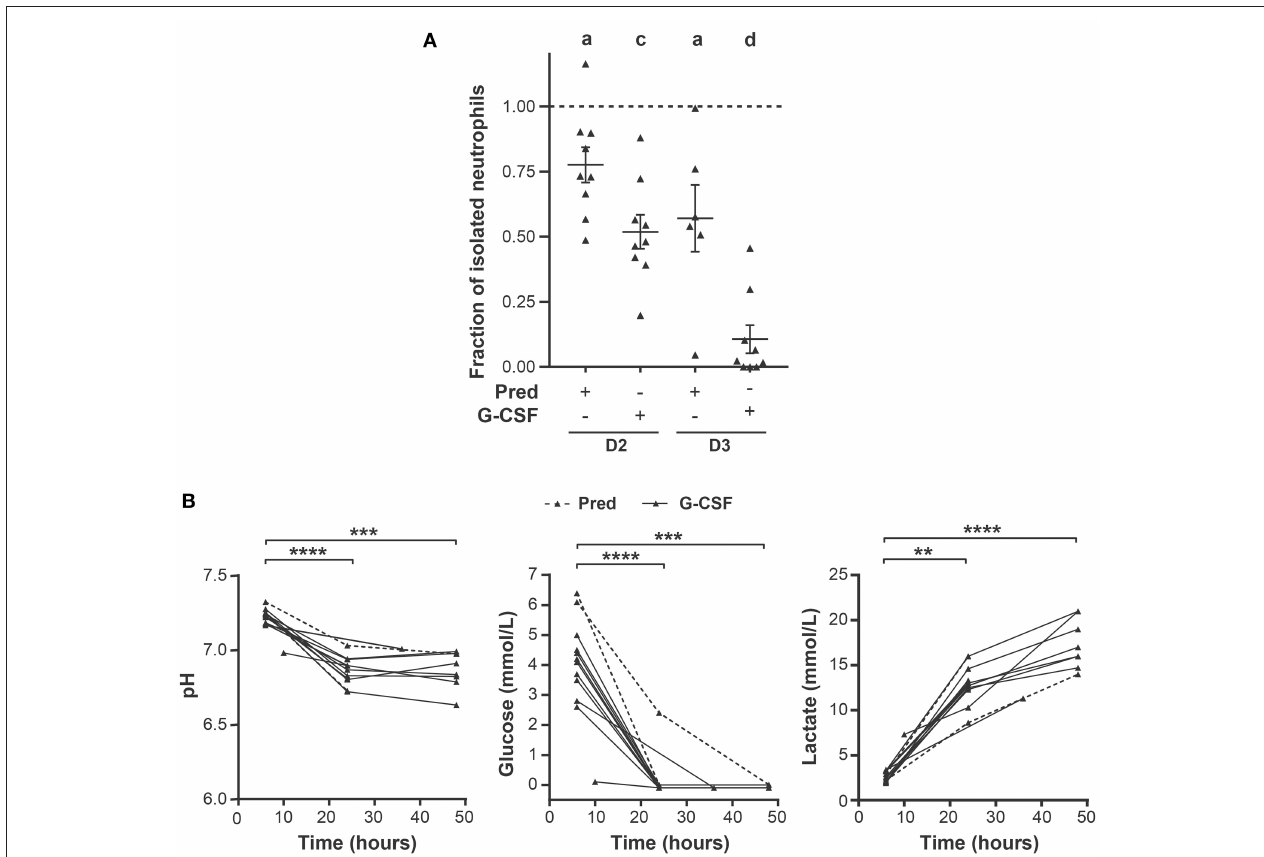
FIGURE 5 | Effect of storage on neutrophil isolation from GCs and GC metabolite composition. (A) Ratio of the number of neutrophils isolated with a density gradient 24h (D2) or 48h (D3) post-leukapheresis, and the number of neutrophils isolated from GCs right after leukapheresis (D1); (D2/D1 and D3/D1). Sample size: D1 ( n = 9), D2 ( n = 9), D3 ( n = 7). Cell counting was performed with a hemacytometer after trypan blue staining. The dashed line corresponds to a ratio of 1. (B) The pH (left), glucose (middle) and lactate (right) concentrations were measured in GCs after the indicated times of storage. Prednisone, dashed line ( n = 2), G-CSF solid line , ( n = 10). Statistical analysis: A sample t test with a theorical mean of 1 was performed in (A) , a p -value < 0.05; c p -value < 0.001 and d p -value < 0.0001. Sidak multiple comparison test was performed to compare GC metabolite content at 24 or 48h of storage with that after 6h of storage in (B) , ** p -value < 0.01; *** p -value < 0.001; **** p -value <